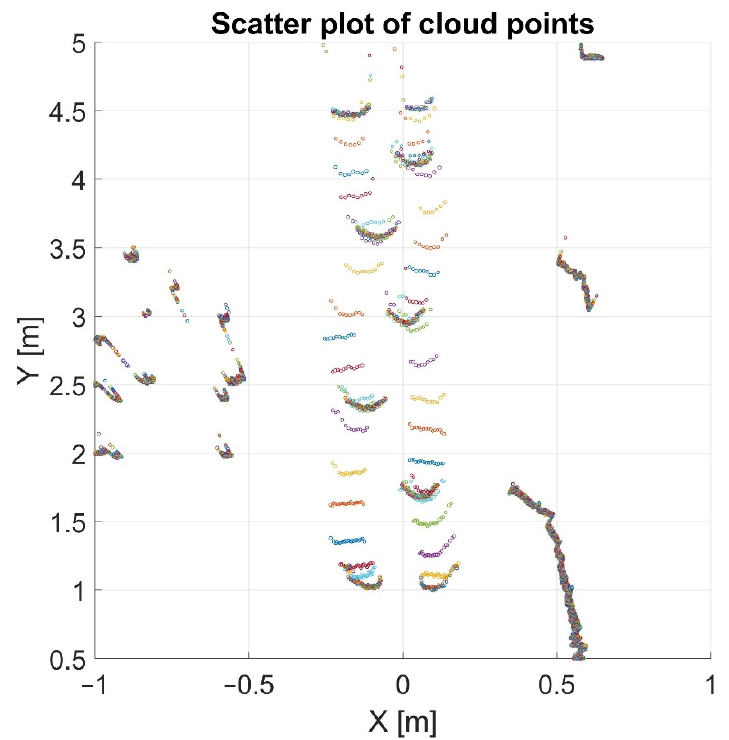
Figure 6. Scatter plot of the cloud points after frame extraction.